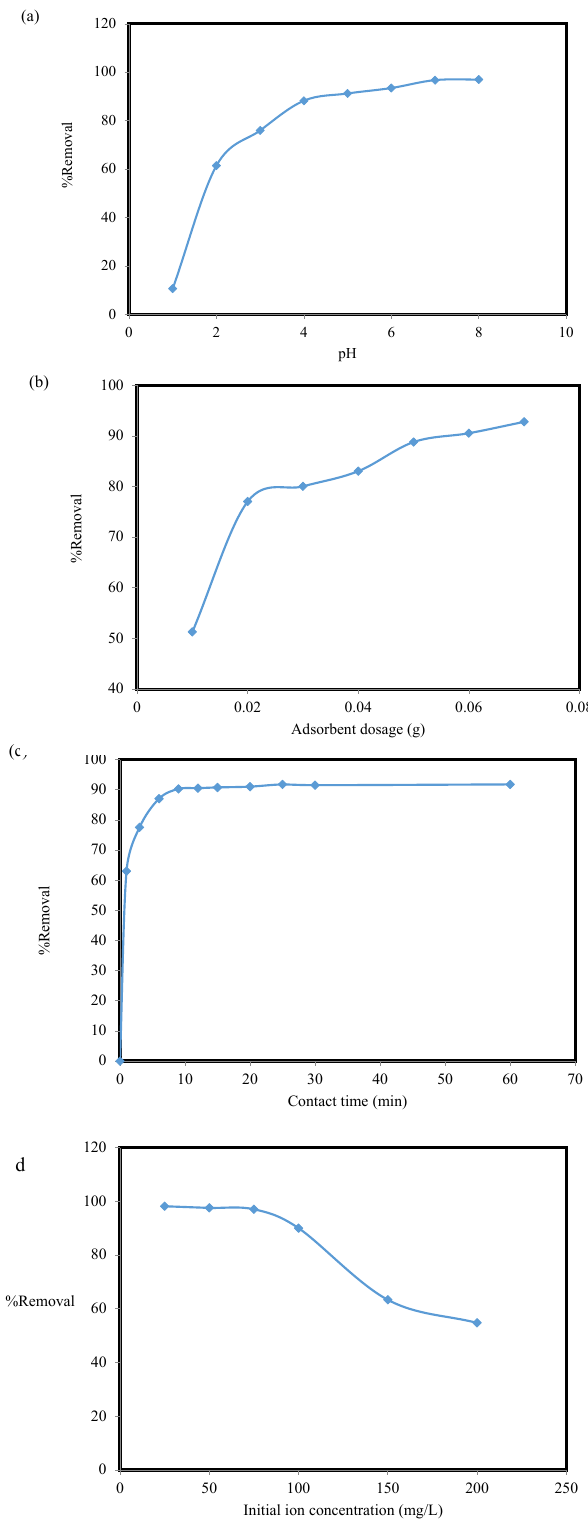
Fig. 9 (a) The effect of pH, (b) The effect of adsorbent dosage, (c) The effect of contact time, and (d) The effect of initial concentration on the sorption of Pb (II) onto